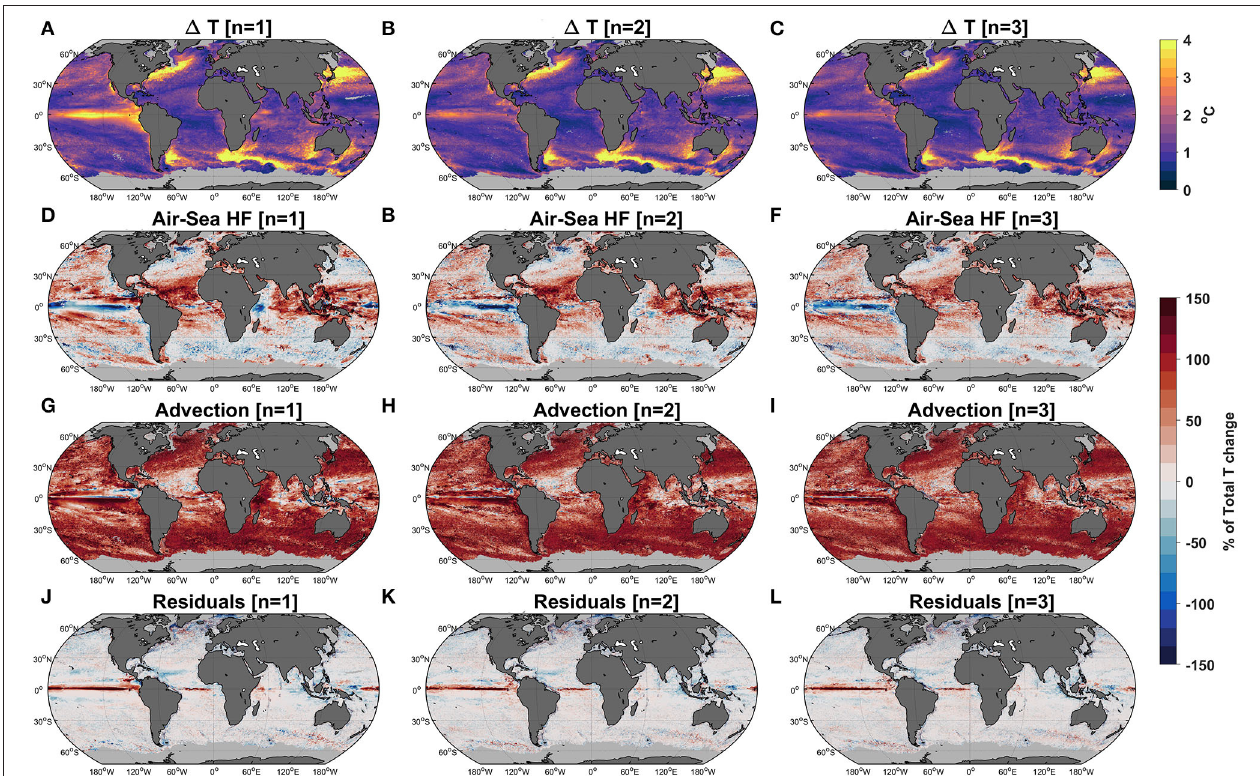
FIGURE 2 | Heat budget results for the onset of the three strongest MHW events. (A–C) Total depth-averaged temperature anomaly change. The contribution from (D–F) total air-sea heat flux and (G–I) heat advection anomaly terms are shown as a percentage of the total temperature change. (J–L) The remaining temperature change that was not explained by either total air-sea heat flux nor advection are termed residuals. As temperature change is, by definition, positive during the onset period, positive/negative percentages indicate a warming/cooling contribution. Grid points where onset periods started before Jan-1st 1984 or with sea-ice contamination were excluded from the analysis (gray